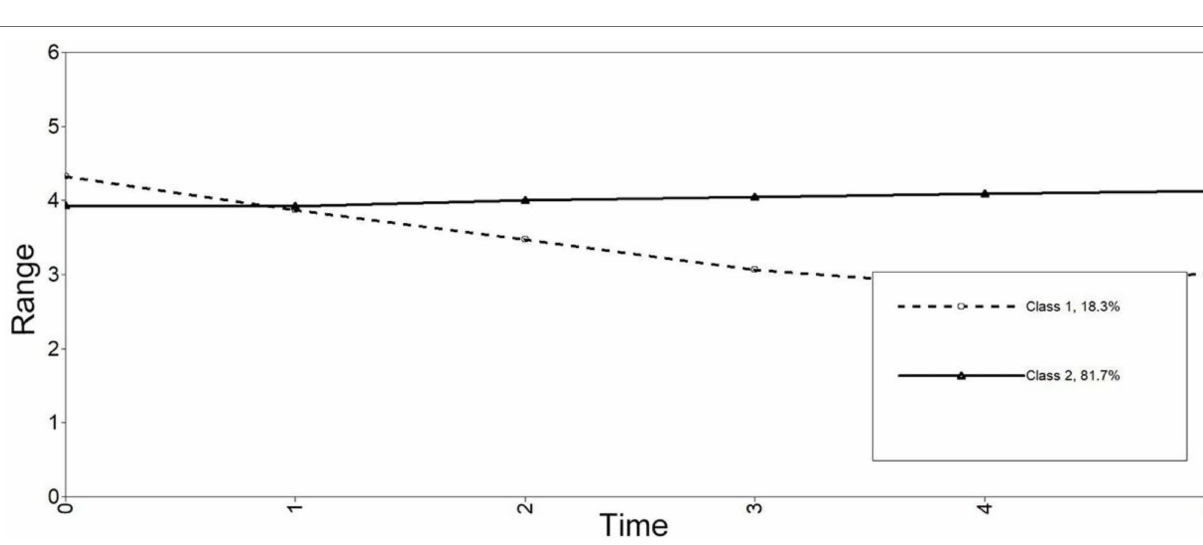
FIGURE 3 | Estimated longitudinal trajectories of anxiety for 2-class.